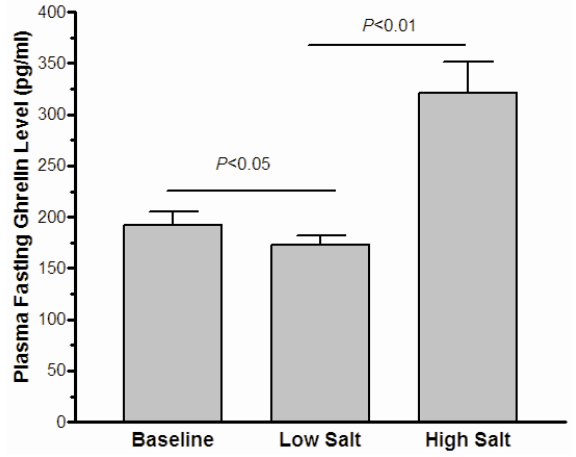
Figure 1. The effect of low ‐ salt and high ‐ salt intake on fasting ghrelin in all subjects.